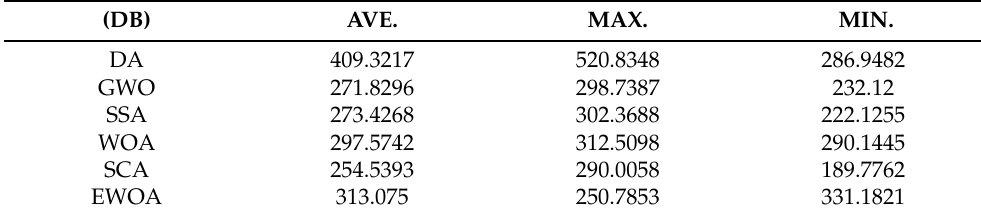
Table 2. Statistical results of the running time obtained by different approaches. (DB) AVE. MAX. MIN.